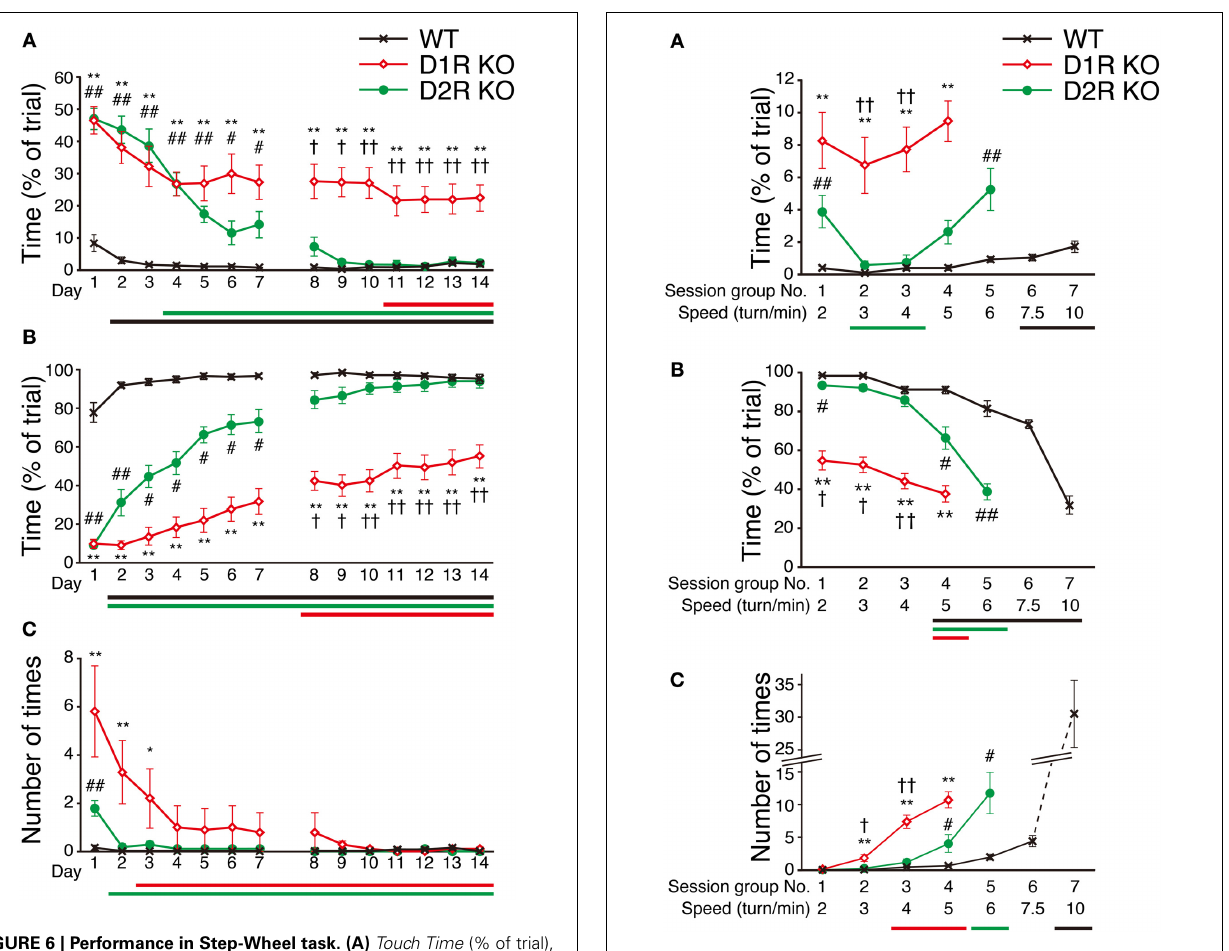
FIGURE 7 | Performance at various speeds in Step-Wheel Task. (A) Touch Time (% of trial), (B) Water On Time (% of trial), and (C) number of Turn Stops at various turning speeds are represented as group means ± s.e.m. over 5 trials in each group of sessions. The turning speed was set to 2, 3, 4, 5, 6, 7.5, and 10 turns/min, from the 1st to 7th group of sessions, respectively. WT mice (black crosses, n = 13), D1R KO mice (red diamonds, n = 10), D2R KO mice (green circles, n = 10). Significantly different performances between genotypes were found in the group of sessions marked by ∗∗ p < 0 . 01 for D1R KO mice vs. WT mice; # p < 0 . 05, ## p < 0 . 01 for D2R KO mice vs. WT mice; † p < 0 . 01, †† p < 0 . 01 for D1R KO mice vs. D2R KO mice (Kruskal–Wallis test). Significant differences from the 1st group of sessions were found in the groups of sessions marked by horizontal bars shown under the graphs ( p < 0 . 05, Dunnett test; WT, black; D1R KO, red; D2R KO,